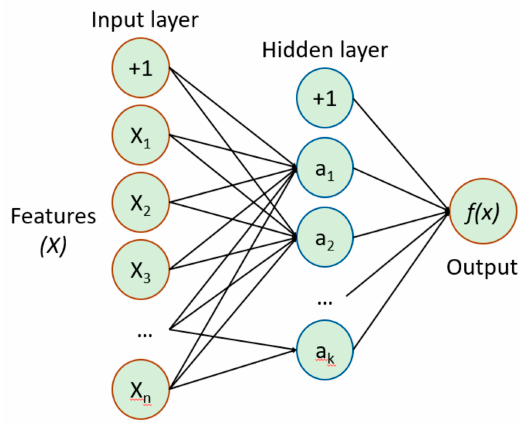
Figure 4. Multilayer perceptron network with one hidden